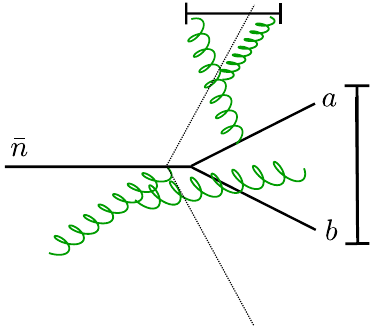
Figure 2 . Illustration of how emissions outside the jet can cluster with emissions within the initial angular region set by the subjet splitting. The initial angular region that sets the resummation of global sudakov e(cid:11)ects is given by the dashed lines. Some clustering can remove emissions that would naively contribute to D 2